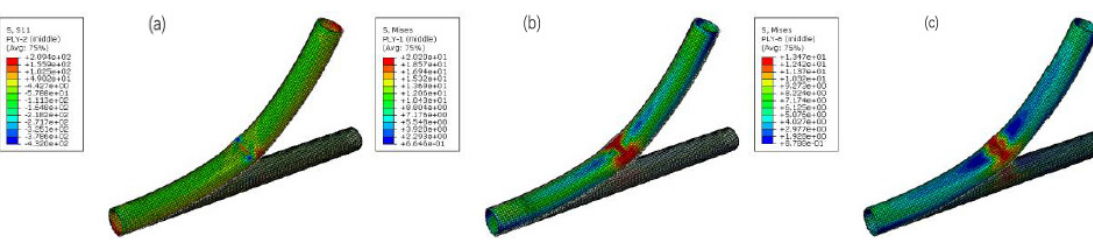
8 of 14 Figure 9. Curves of stress with axial tensile displacement: ( a ) inner liner; ( b ) outer cover. 3.2. Flexure Analysis of RTP The RTP being reeled onto a spool experiences large deformations. The geometrically non-linear approachwas employed to simulate the mechanical behavior of the RTP under coiled bending. The Nlgeom option was chosen in the general static solution procedure of the ABAQUS/Standardto solvethe non-linear problem. Riks analysis step was used to sim- ulate the bending process.It uses the load magnitude as an additional unknown and solves for loads and displacements simultaneously. The Riks method follows an eigen value buckling analysis to provide complete information about a structure’s failure. At the eigen value calculated by Riks, the stress distributions of each layer of the RTP are shown in Figure 10. An obvious stress concentration and buckling were observed in the middle of each layer due to bending action. The maximum stress value of the rein-